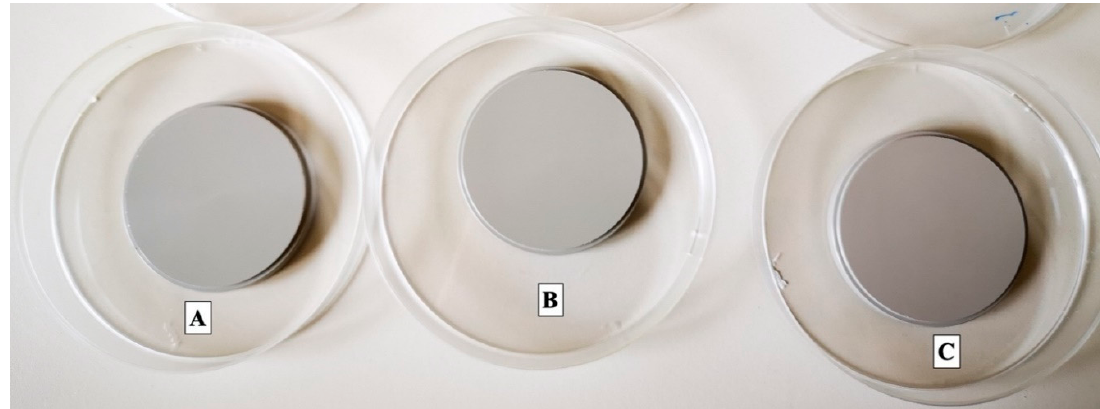
Figure 2. Representative image of aluminum disks with different roughness, ( A ) R0.25, ( B ) R0.5 and ( C ) R1 μ m, treated with DURALTI ® .